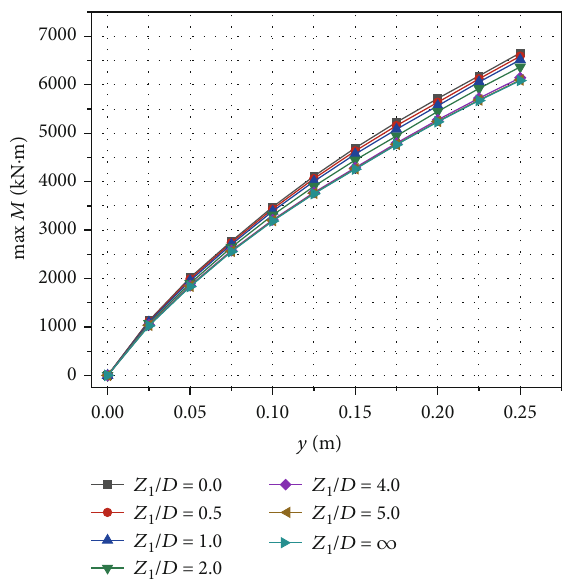
/ D on the de fl ection of the pile head. 1